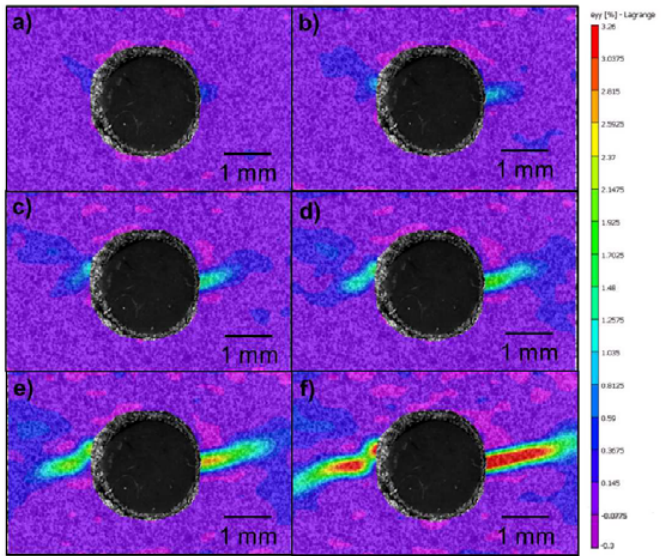
Figure 7: Crack growth as determined by digital image correlation (DIC). Number of cycles (N): (a) 100 000, (b) 130 000, (c) 160 000, (d) 180 000, (e) 210 000, (f) 230